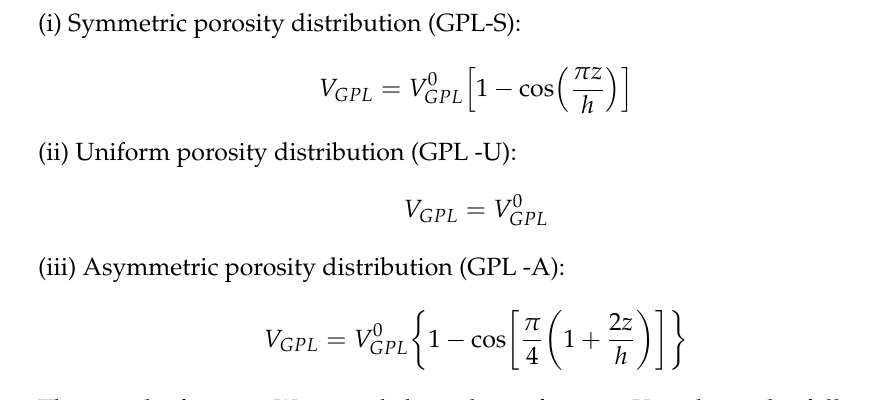
Figure 3. Schematic of GPL dispersion patterns.